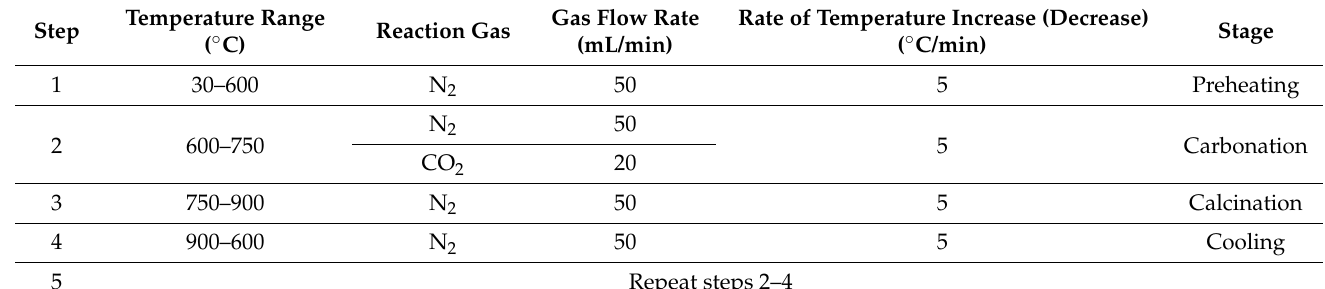
Table 1. Experimental conditions for cyclic